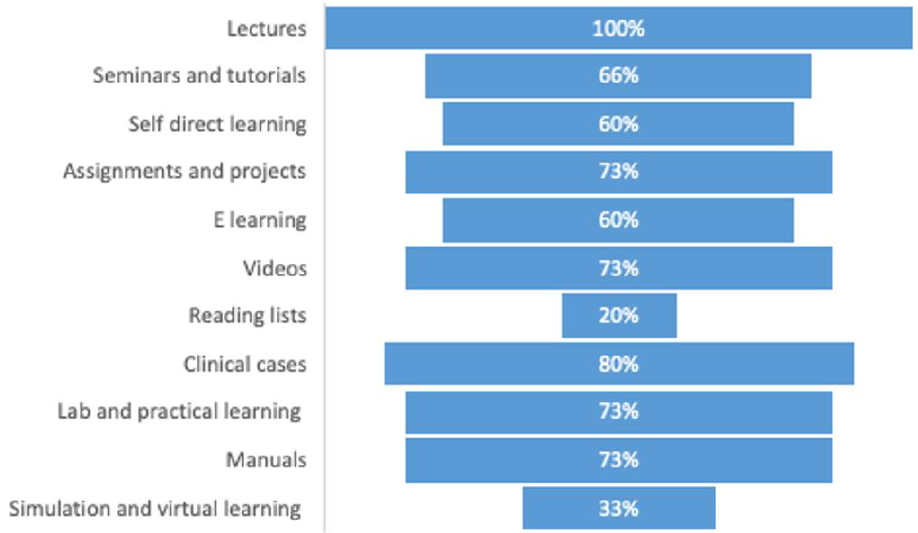
Figure 2. Percentage distribution of teaching strategies used in Saudi colleges.